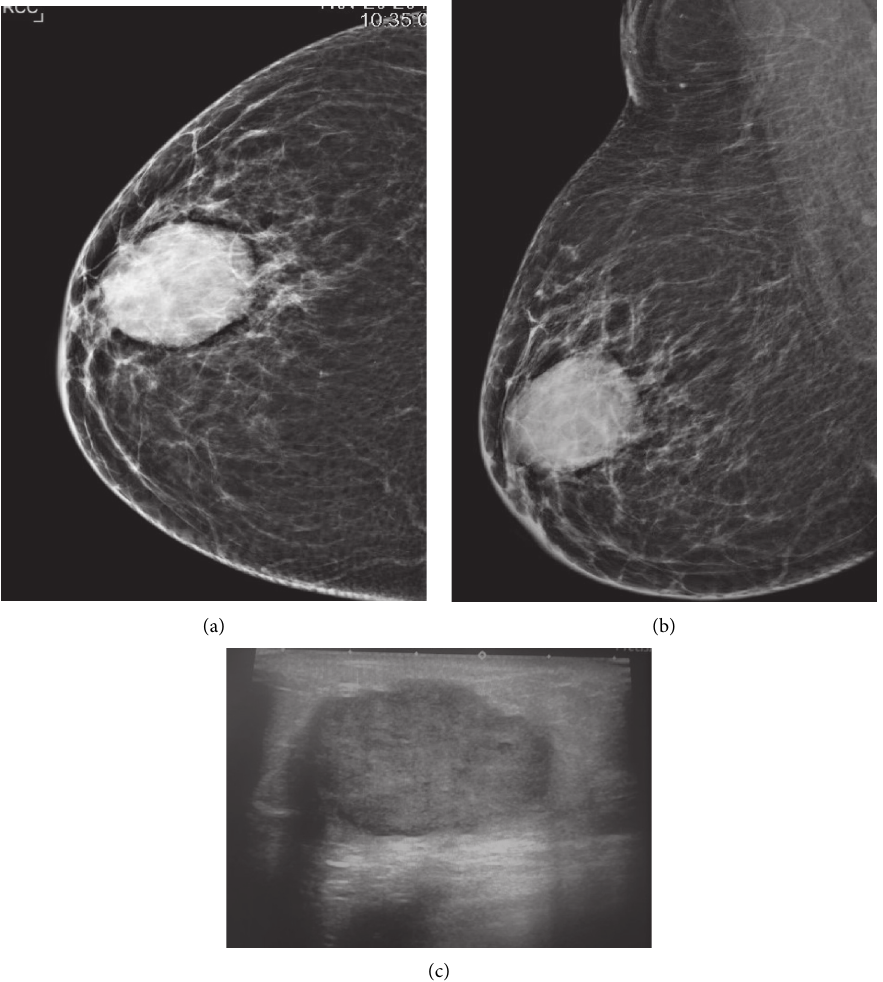
Figure 5: CC and MLO views of right breast. (a) Biopsy-proven metaplastic carcinoma triple-negative (grade III). There is an oval-shaped high-density mass in retroareolar region. Well-defined margins are seen. (b) Peripheral lucent halo is also seen. No microcalcifications are identified. (c) Ultrasound of the same patient shows a hypoechoic mass with microlobulated margins. Posterior acoustic enhancement is seen. Abrupt boundary with antiparallel orientation is also noticed. Sono-mammometry score �